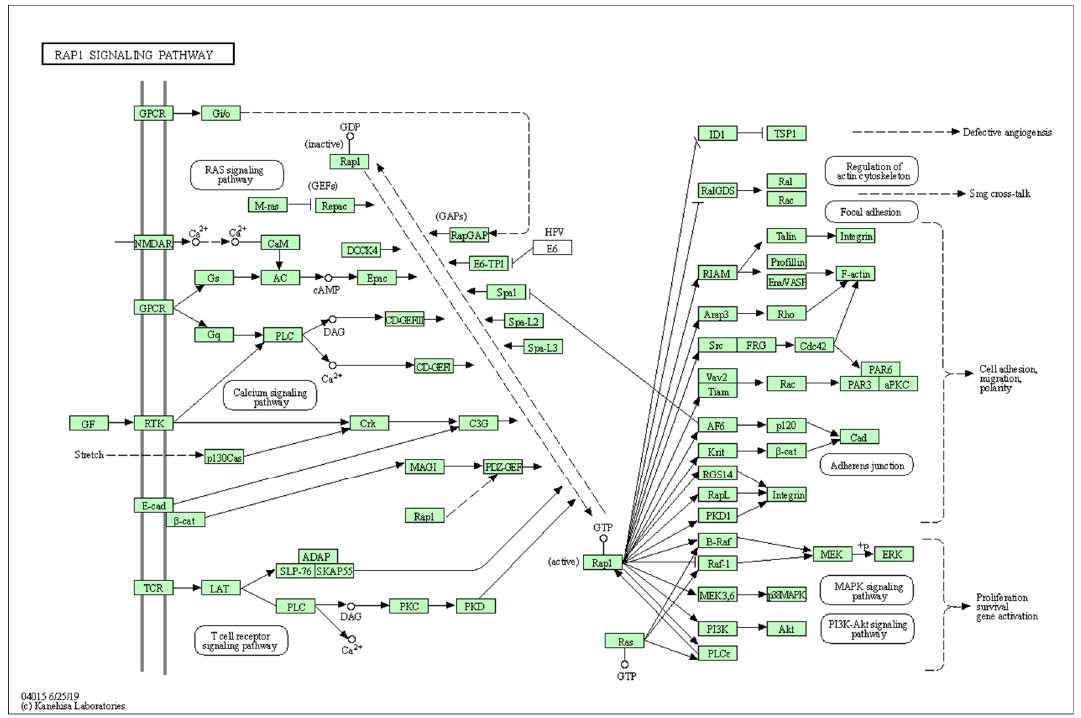
Figure A7. RAP1 signaling pathway, KEGG pathway. KEGG, Kyoto Encyclopedia of Genes and Genomes. Copyright permission obtained.